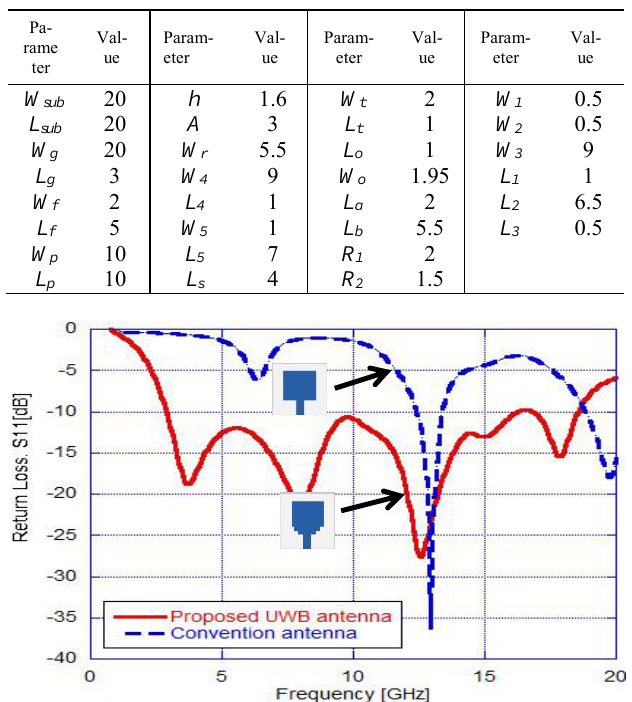
Table 1: Optimal design parameters of the final design (all